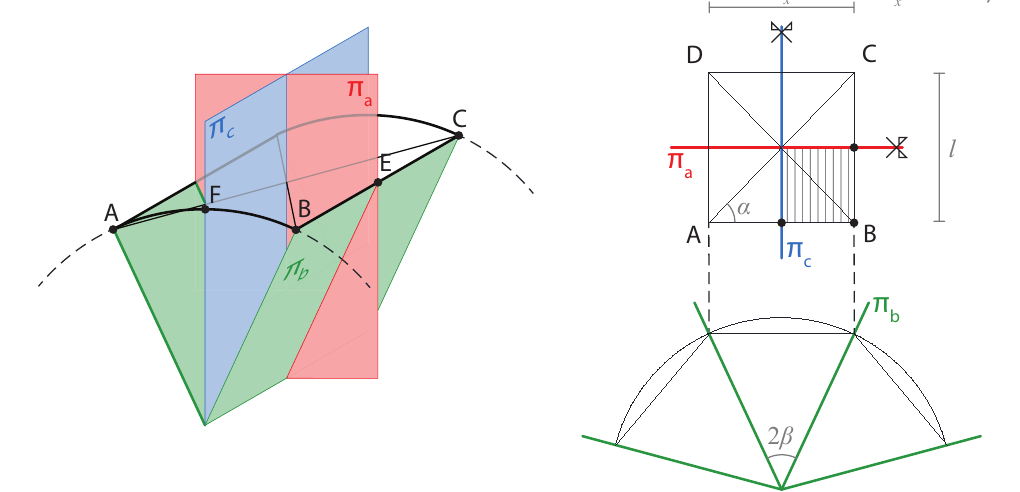
Figure 4. Symmetries of the problems. ( Left ) 3D view. ( Right ) Top and Front view. The symmetries of the REV (w.r.t. π a and π c ) together with periodicity conditions (w.r.t. π b ) enable to impose the boundary conditions required to eliminate rigid displacements of the